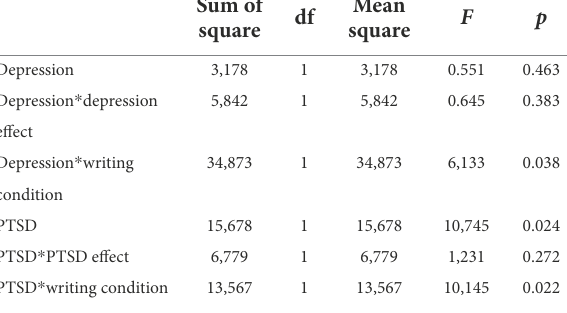
TABLE 2 Repeated-measure